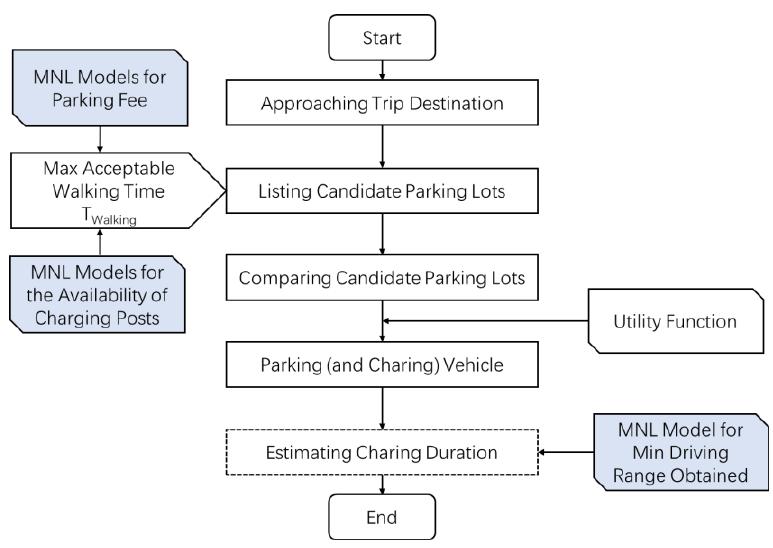
Figure 5. Illustration of parking and charging behaviour modelling.